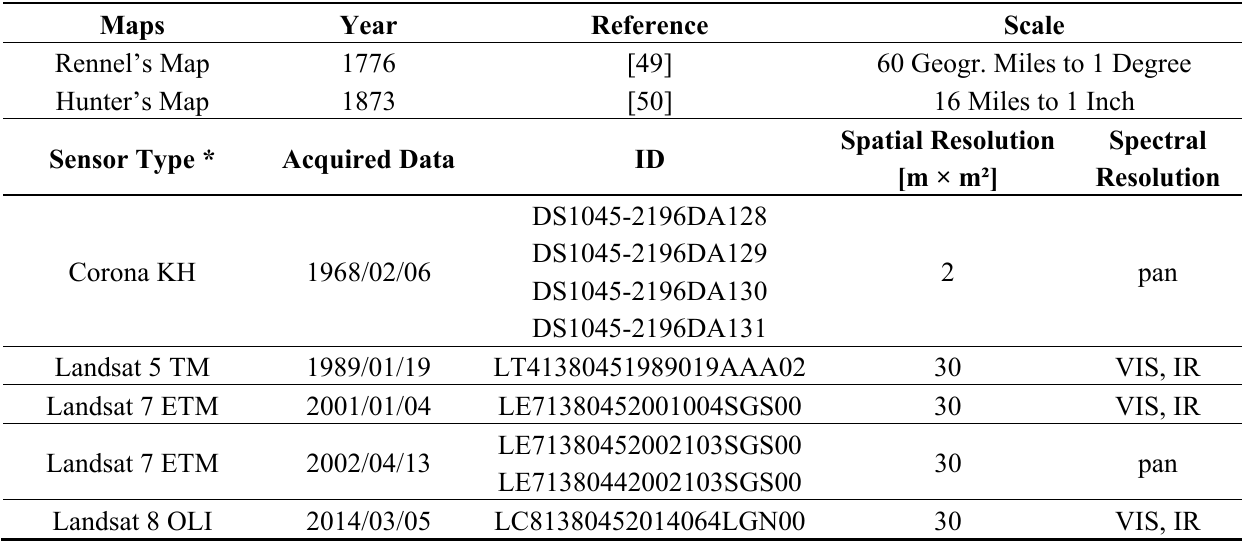
Table 1. Historical maps and satellite data employed in this study Maps Year Reference Scale Rennel’s Map 1776 [49] 60 Geogr. Miles to 1 Degree Hunter’s Map 1873 [50] 16 Miles to 1 Inch Spatial Resolution Sensor Type * Acquired Data ID [m × m²]